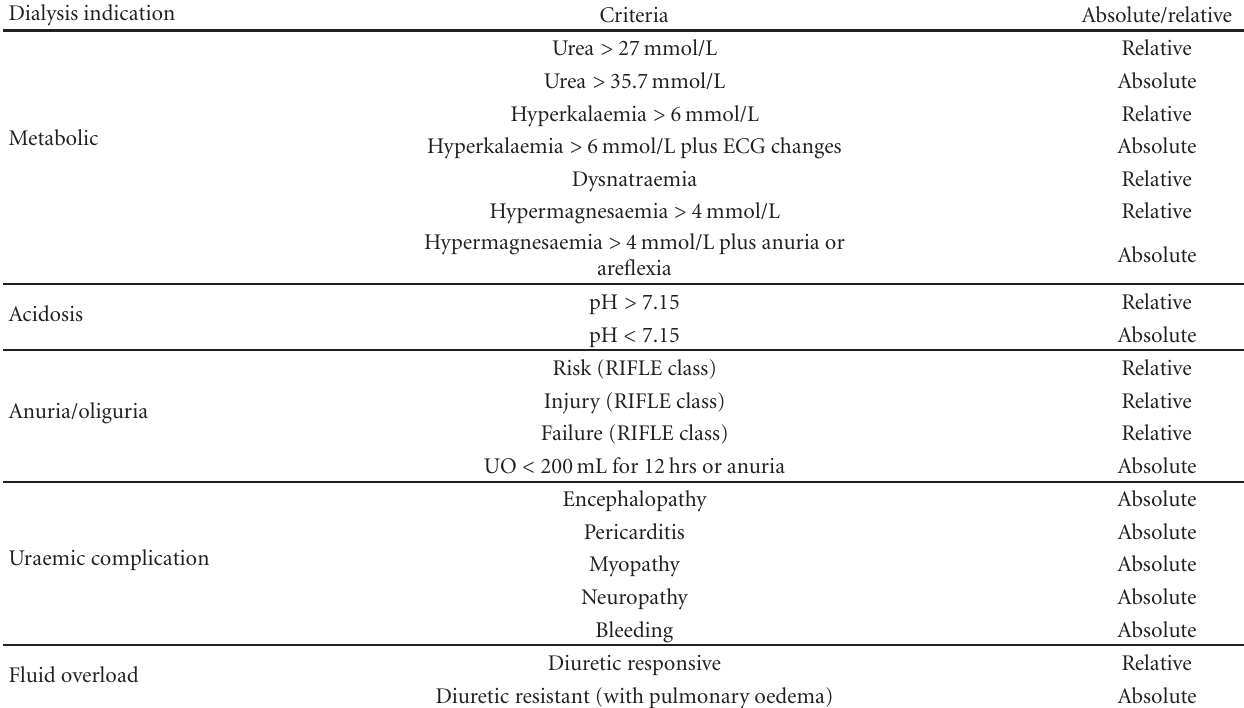
Table 3: Recommended relative and absolute indications for RRT in critically ill patients with AKI